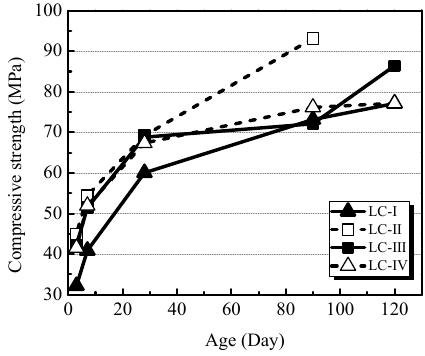
Figure 2. The development of compressive strength on average.